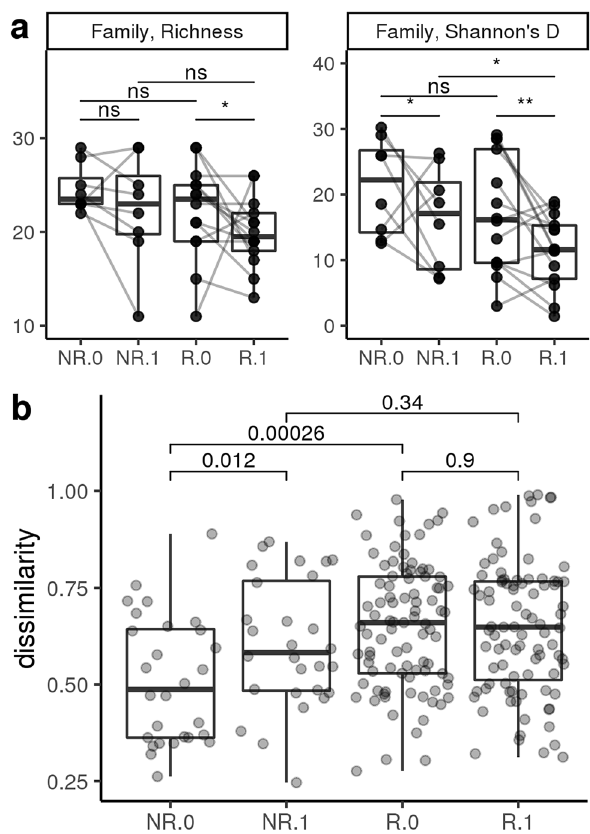
Figure 4. Diversity measures at the family level of chronic enteropathy (CE) cats at time of diagnosis and post dietary intervention. NR = non-responder, R = responder, 0 = time of diagnosis, 1 = post dietary intervention ( a ) Family richness (left panel) is decreased in responders but remains unchanged in non-responders. Diversity as measured by Shannon’s Diversity Index (right panel) is decreased after dietary treatment, regardless of clinical response to the dietary intervention. Adjusted p-value < 0.0001 represented with ***. Adjusted p-value < 0.001 represented with **. Adjusted p-value < 0.01 represented with *. Adjusted P -value > 0.05 represented with ns. ( b ) Sample dissimilarity shows that non-responders become more dissimilar after dietary intervention. On the other hand, responders maintain the same level of sample dissimilarity after dietary intervention, even though responders are more heterogeneous in β-diversity than non-responders at the time of